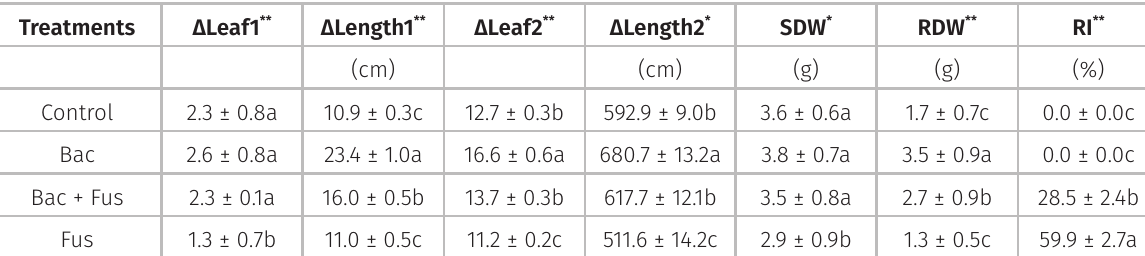
Table IV. Morphophysiological responses in micropropagated rootstock SO4: variation of leaf number after 30 days (ΔLeaf1), variation of shoot length after 30 days (ΔLength1), variation of leaf number after 160 days (ΔLeaf2), variation of shoot length after 160 days (ΔLength2), shoot dry weight (SDW), root dry weight (RDW) and frequency F. oxysporum re-isolation (RI), in four different treatments: control, B. subtilis F62 (Bac), B. subtilis F62 + FusTD901 (Bac + Fus) and FusTD901 (Fus).